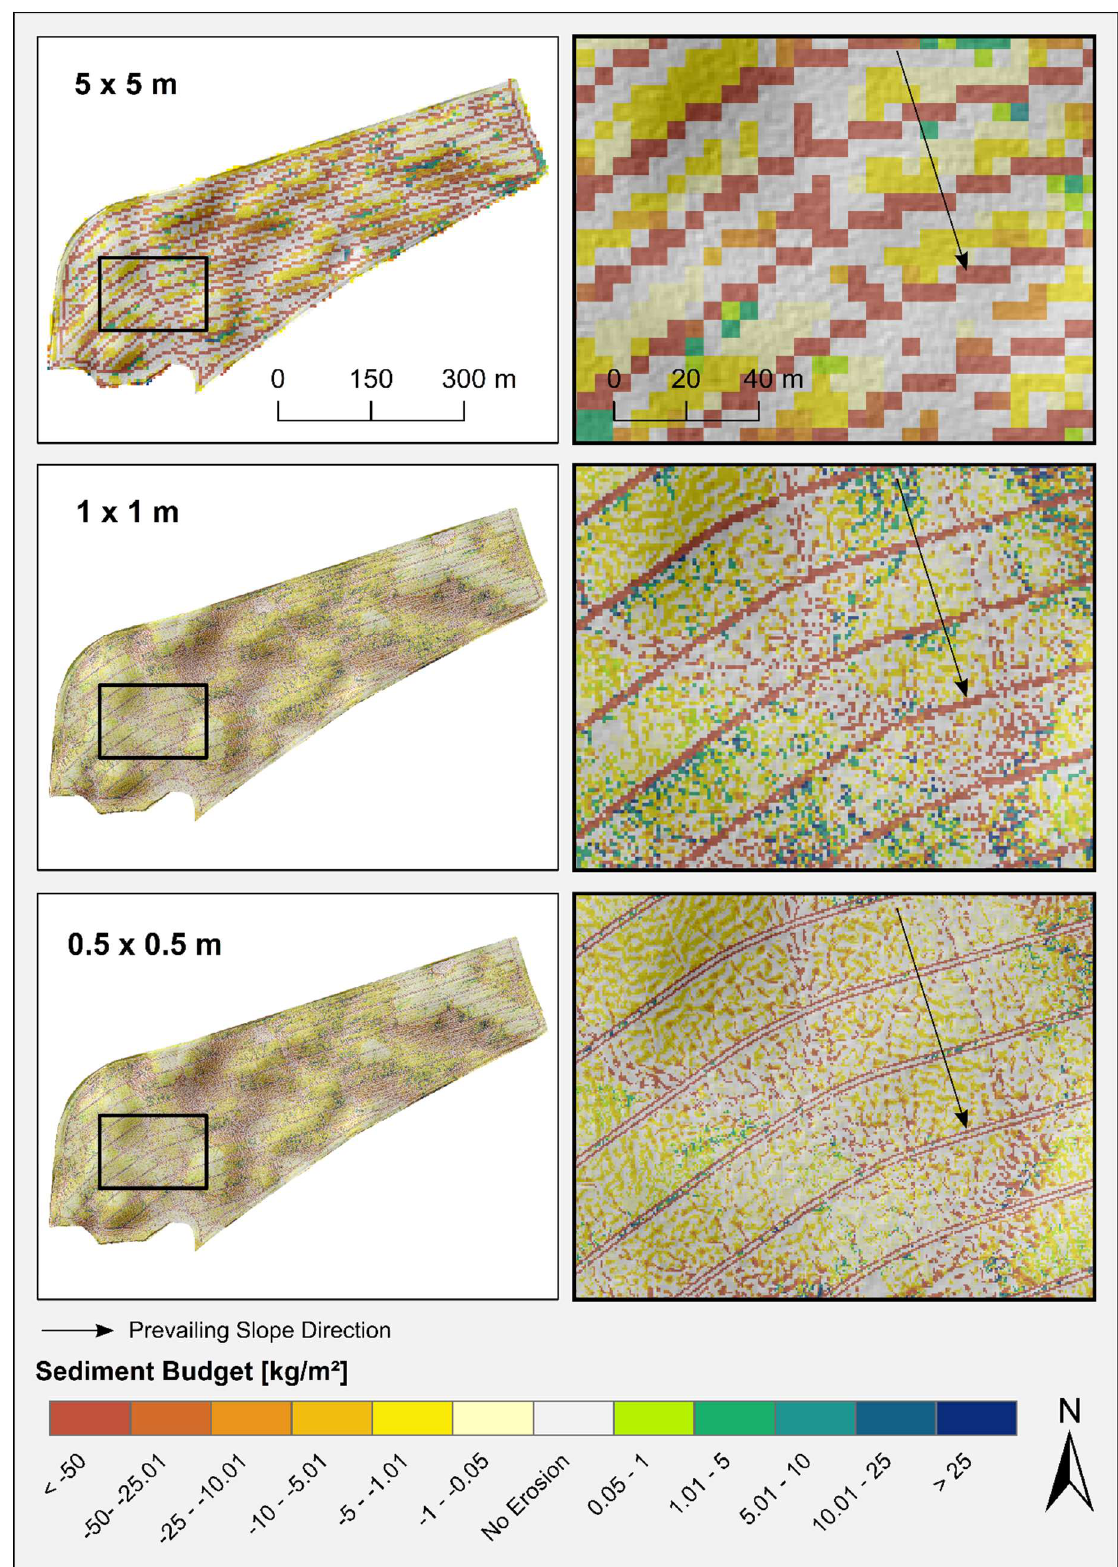
Figure A2. Visualization of simulated sediment budget from EROSION 3D for investigated resolutions on field B.